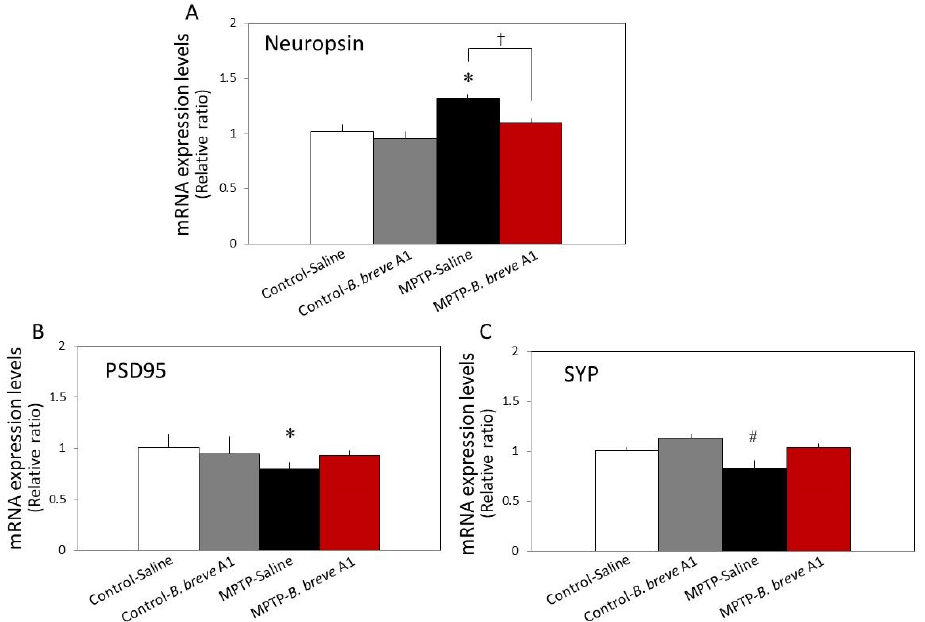
Figure 4. RT–qPCR analysis of the hippocampal mRNA expression levels of neuropsin ( A ), PSD95 ( B ), and SYP ( C ) in saline-administered controls and PD mice, and in B. breve A1-administered controls and PD mice. Data are expressed as the mean ± SEM: n = 7–9 per group. * p < 0.01 and # p < 0.05 vs. Control + saline and † p < 0.05: between MPTP + Saline and MPTP + B. breve A1. On the other hand, no significant differences were seen in the levels of ionized calcium-binding adapter molecule 1 (Iba1) and brain-derived neurotrophic factor (BDNF)